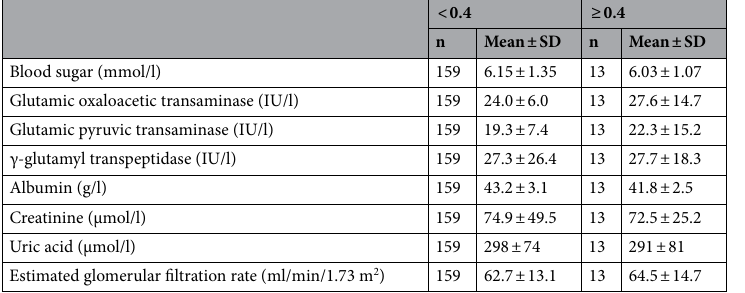
Table 1. Characteristics of subjects with Jensen-Shannon distance (JSD) < 0.4 or ≥ 0.4. Intergroup differences in the ratio of male/female, smoker/nonsmoker, alcohol consumer/non-alcohol consumer, and medicated/ non-medicated were assessed by chi-square tests. Independent differences in each of the other variables between groups were assessed by analyses of covariance, after adjusting data on age for sex and the others for age and sex. * P < 0.05 versus JSD < 0.4.